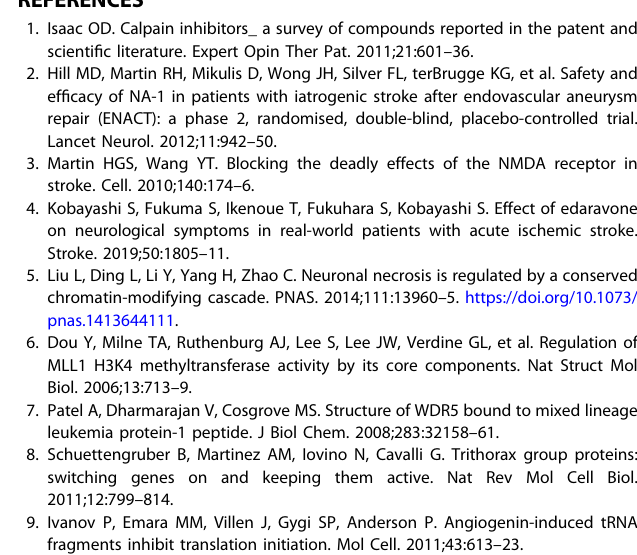
Fig. 7 Proteomic analysis of the AG fl ies. Proteomic analysis was performed before and after the induction of neuronal necrosis in the AG fl ies. A Compared to the control ( AG fl ies without induction of necrosis), the top 10 enriched GO annotations and KEGG pathway analysis of downregulated proteins are listed. Three independent samples were collected and analyzed as a group. B Characterization of the proteomic pro fi le of Ago2RNAi in the AG fl y. Two protein pro fi les were obtained. One was the “ necrotic pro fi le ” , which was obtained by comparison of the necrotic AG fl ies with the AG fl ies without induction of necrosis. The other one was “ Ago2RNAi rescue of necrotic pro fi le ” , which was obtained by comparison of AG (induced necrosis) vs AG (induced necrosis under the Ago2RNAi background). Compared the two protein pro fi les, the reversed protein pro fi le of Ago2RNAi against the “ necrotic pro fi le ” was performed the GO and KEGG pathway analysis. C The morphological change of mitochondria in the AG fl ies. To label mitochondria, the UAS-mitoGFP line was crossed into the AG background. At 30 °C, the mitochondria of neurons in the wild type fl ies Appl > mitoGFP ; tub-gal80 ts (genotype: Appl-Gal4/ + ; tubulin-gal80 ts / + ; UAS-mitoGFP/ + ) displays a typical morphology with elongated shape in the Ch N. In contrast, activation of neuronal necrosis resulted in fragmentation of mitochondria in the AG (genotype: Appl-Gal4 / + ; UAS-GluR1 Lc , tubulin-Gal80 ts / + ; UAS-mitoGFP / + ) fl ies. The mutant drp1 ( drp1 1 ) (genotype: Appl-Gal4 / + ; UAS- GluR1 Lc , tubulin-Gal80 ts / drp1 1 ; UAS-mitoGFP / + ) or trx ( trx KG08639 ) (genotype: Appl-Gal4 / + ; UAS-GluR1 Lc , tubulin-Gal80 ts / + ; UAS-mitoGFP / trx KG08639